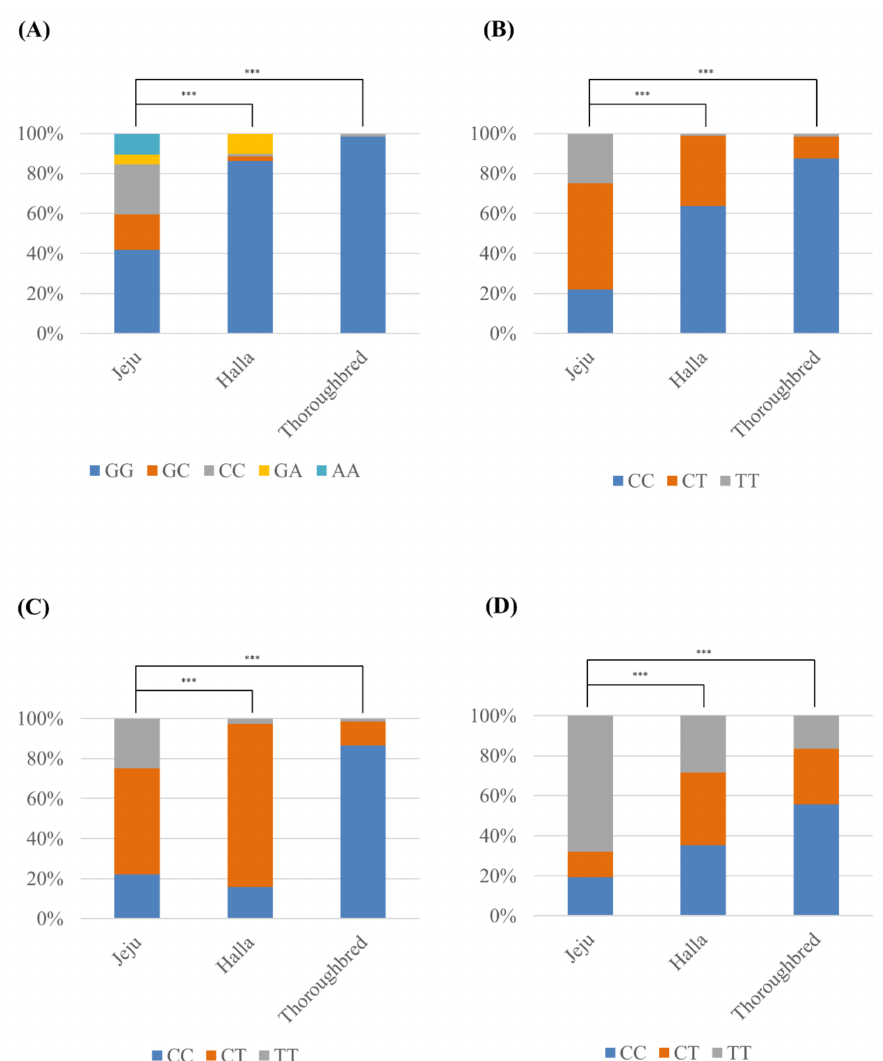
Figure 2. Comparisons of genotype frequency of 4 SNPs identified in 3 horse breeds. The genotype frequencies of c.87G > C, A ( A ), c.502C > T ( B ), c.696C > T ( C ) and c.728C > T ( D ) were compared among the Jeju, Halla and Thoroughbred horses. The difference in genotype frequency was calculated by the chi-square test. Statistically significant differences are indicated. ***: p -value <